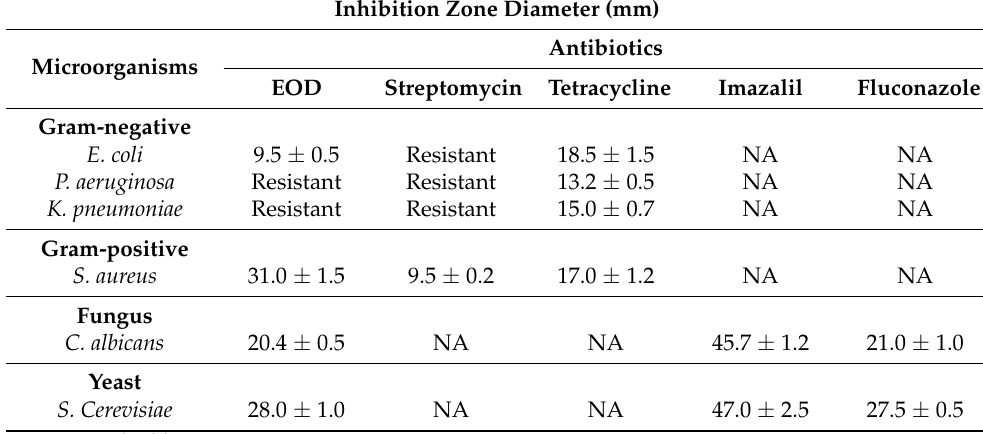
Table 4. Disc diffusion test for essential oil from D. viscosa (EOD), performed on six pathogenic strains and using antibiotics for comparison. Inhibition zone diameter in mm. Results are expressed as mean ± SD.